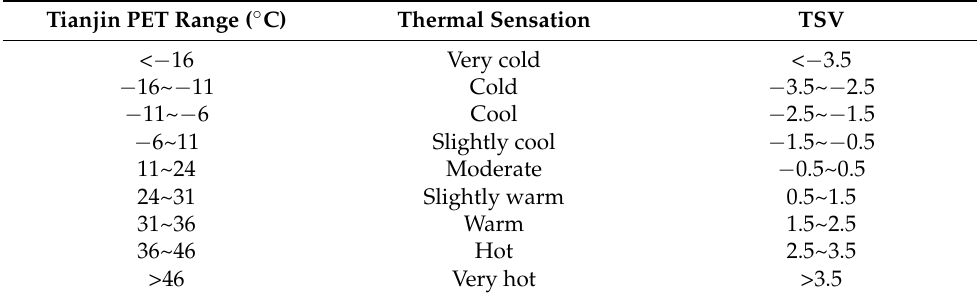
Table 3. PET scale and corresponding thermal sensation in